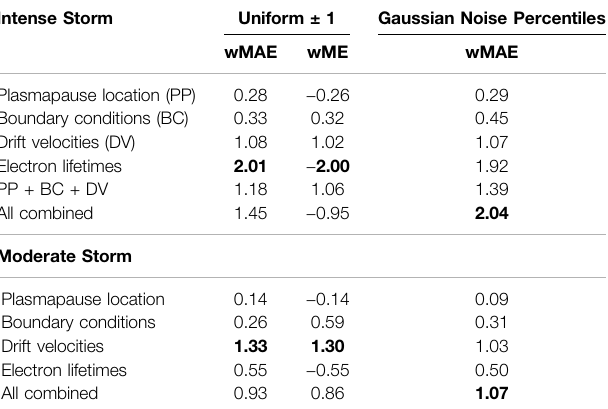
TABLE 2 | Metrics computed for the comparison between the simulation results using uniform offsets, and the results of the 10th and 90th percentile when adding Gaussian noise. For details, see Section 2.2